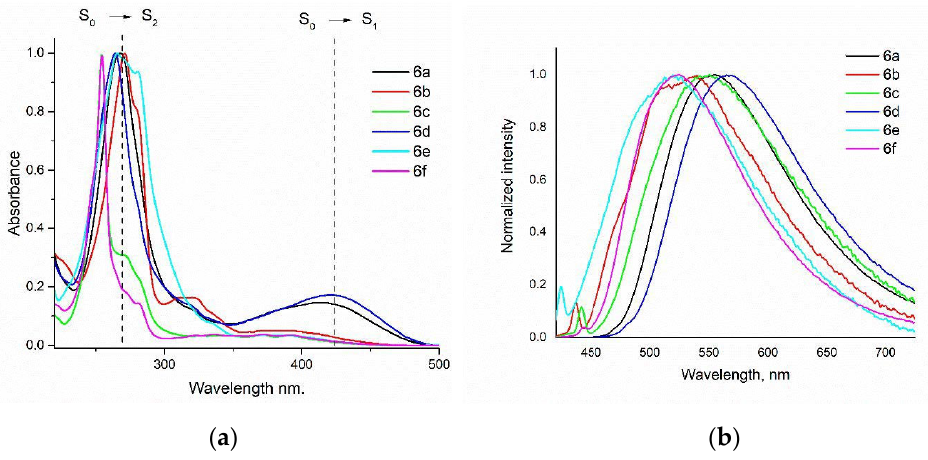
Figure 2. Absorption ( a ) and emission ( b ) spectra of fluorophores 6a–f in THF (c = 10 − 5 M). The absorption spectra of the fluorophores 6a – f are presented by two absorption bands with different intensities at maximum wavelengths in the 220–300 nm and 350–500 nm ranges, which correspond to S 0 → S 2 and S 0 → S 1 transitions. In this case, all the compounds show a dominant absorption band due to the transition S 0 → S 2 with εМ < 14.5 × 104 M − 1 cm − 1 .